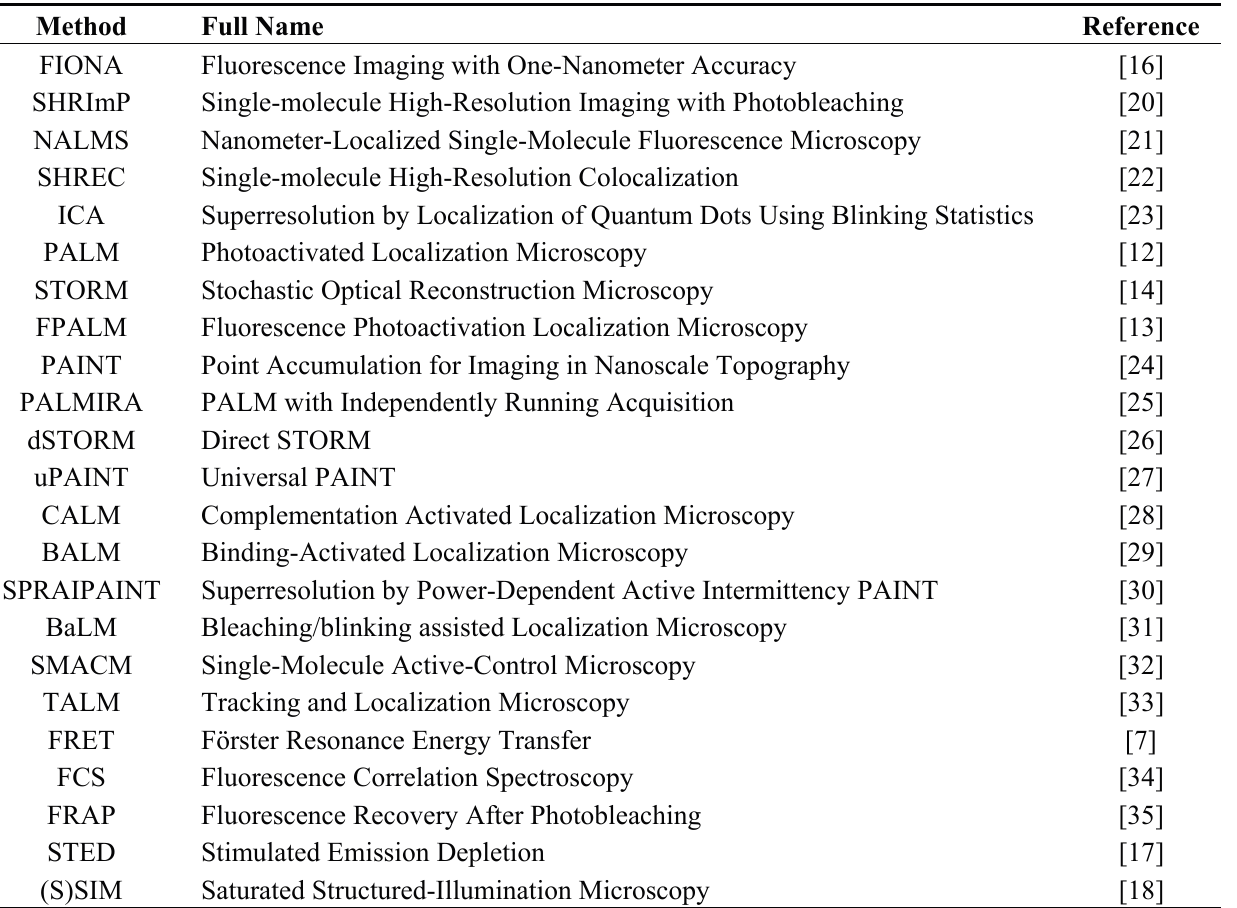
Table 1. Top: Single-molecule fluorescence-based super-resolution imaging and tracking techniques in order of publication. Bottom: Other optical microscopy methods that have been used in live cells and that are discussed in the